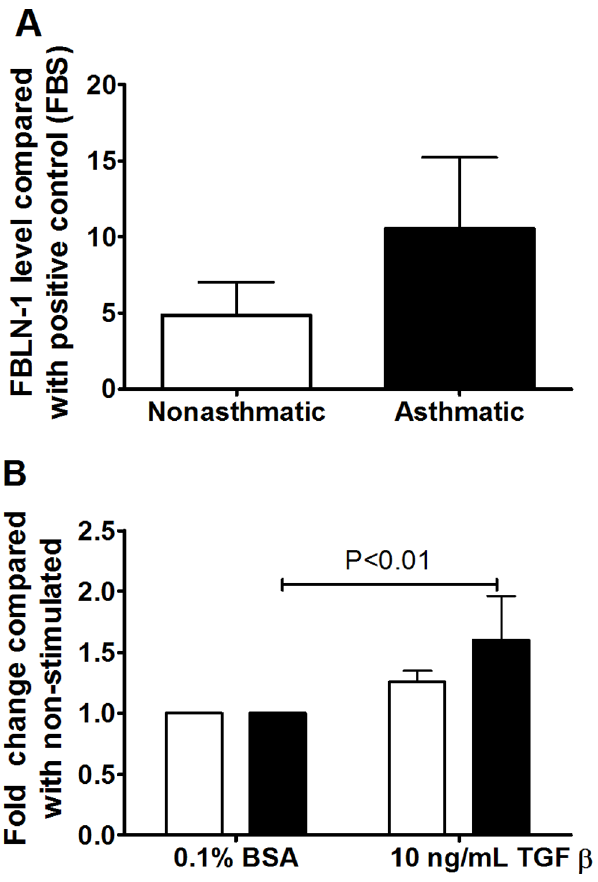
Figure 4. TGF b induced FBLN-1 in ECM produced by asthmatic ASM cells. Basal expression of FBLN-1 (A) deposited by ASM cells collected from non-asthmatic (white bars, n=10) or asthmatic (black bars, n=10) volunteers, or FBLN-1 levels following treatment for 24 h with TGF b (B). Data were normalized to a positive control (50% FBS) and are expressed relative to 0.1% BSA (non-stimulated). Data are expressed as mean 6 SEM.